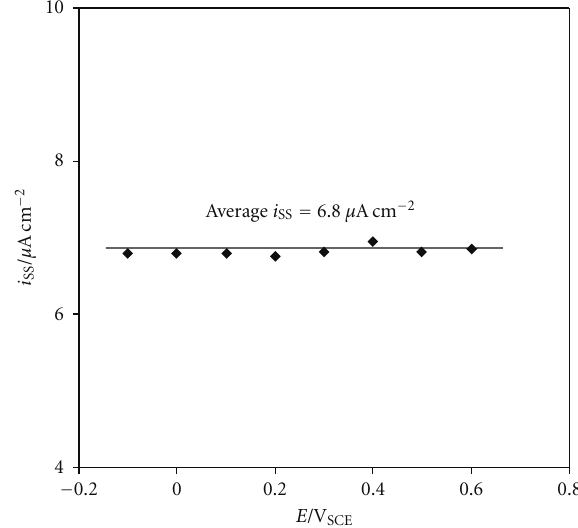
Figure 2: Steady-state current density obtained during the poten- tiostatic growth of the passive films at di ff erent film formation potentials for